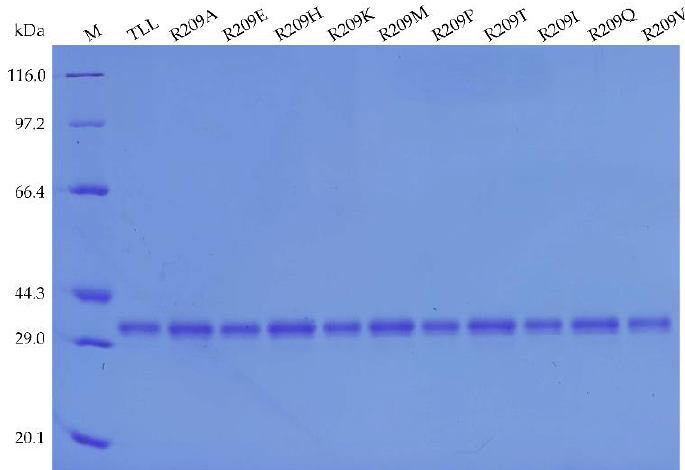
Figure 1. SDS-PAGE analysis of TLL and the ten R209 mutants.